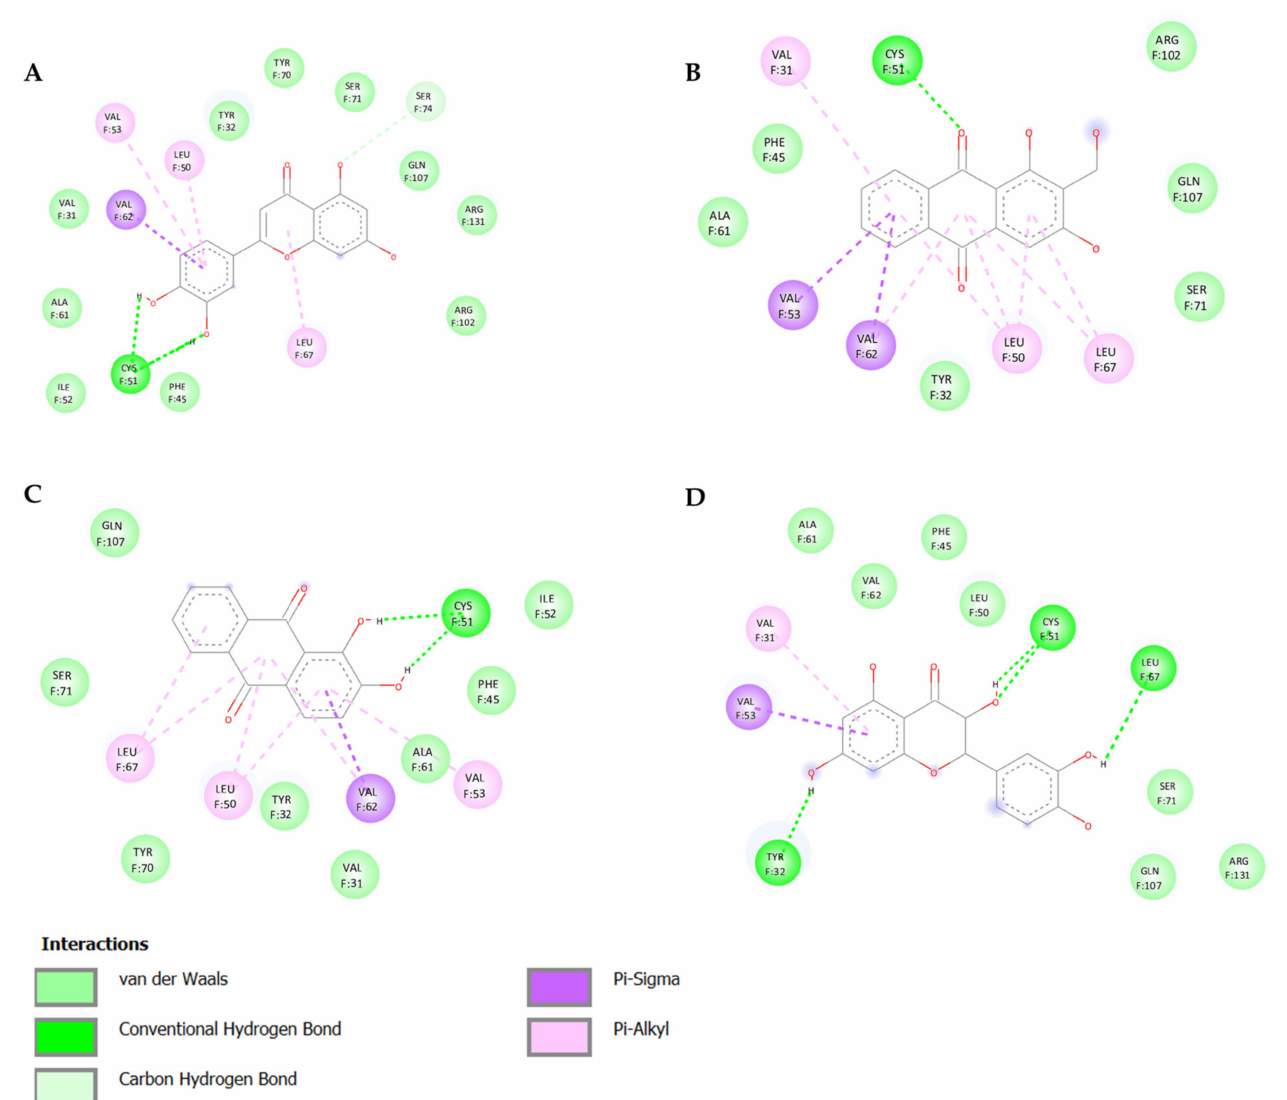
Figure 1. Binding modes and interactions of luteolin ( A ), lucidin ( B ), alizarin ( C ), and taxifolin ( D ) with the HPV16 E6